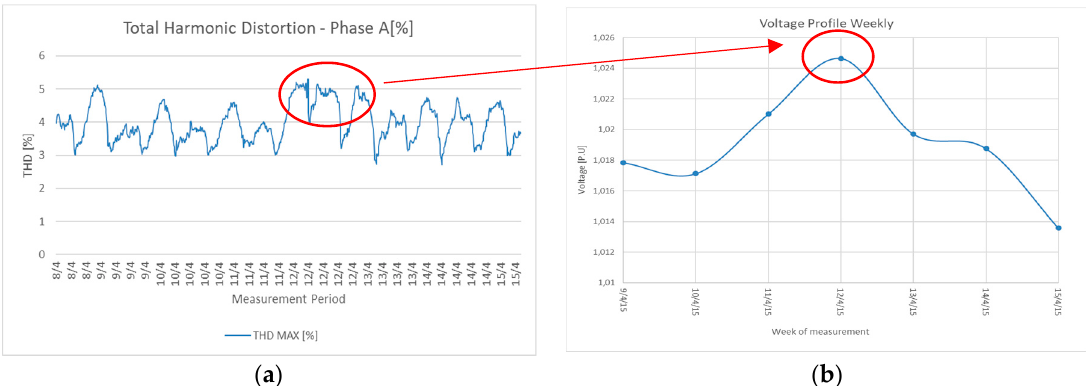
Figure 16. ( a ) The Total Harmonic Distortion for the System and ( b ) voltage rise profile for the